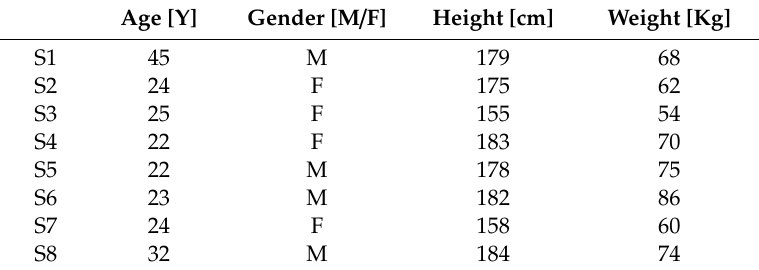
Table 1. Healthy subject’s data; Y: years, M: male, F: female.